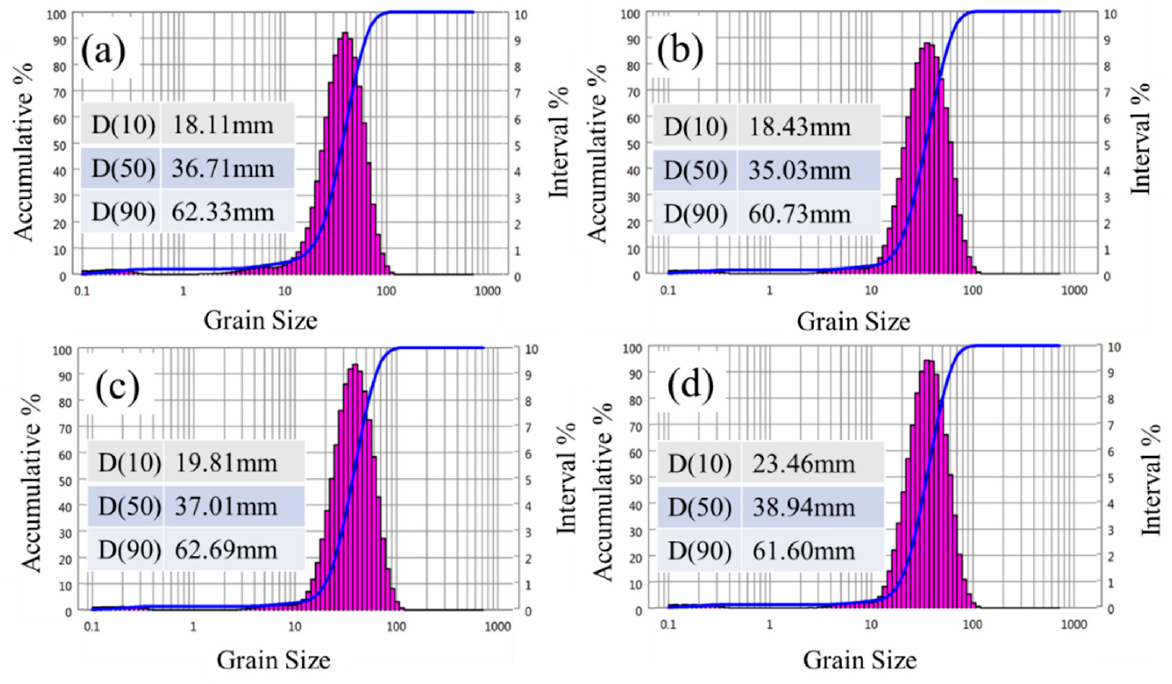
Figure 2. Particle size of Al-6.2Zn-2Mg-xSc-xZr alloys powder, ( a ) sample 1, ( b ) sample 2, ( c ) sample 3, ( d ) sample 4.